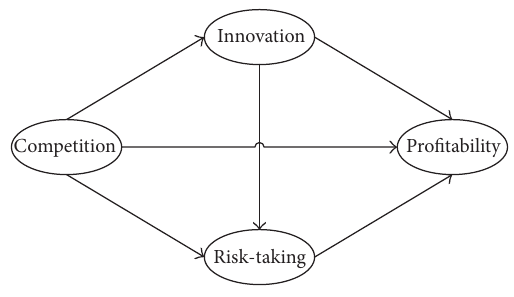
Figure 1: A hypothetical path